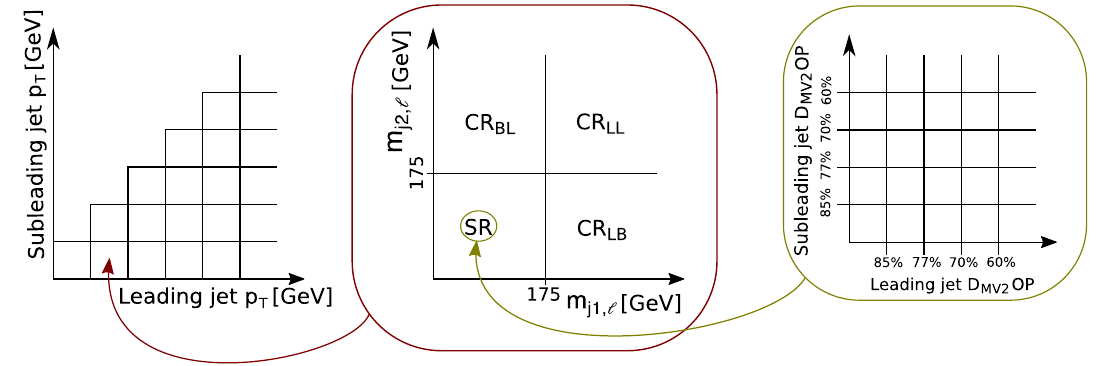
Fig. 6 Schematic illustration of the event categorisation. Events are binned according to the p T of both the leading and subleading jet in the event. In each of these bins, events are further assigned to control